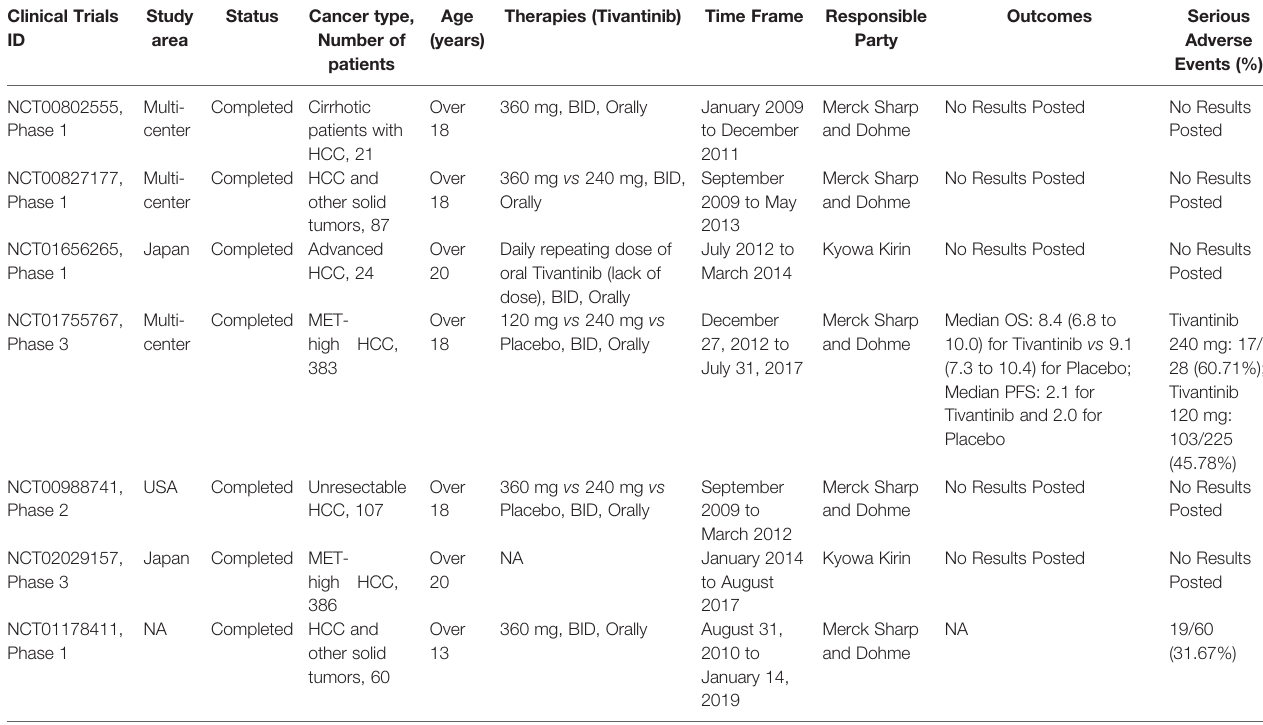
TABLE 1 | Trials of tivantinib in treating HCC registered in the - ClinicalTrials.gov. Clinical Trials